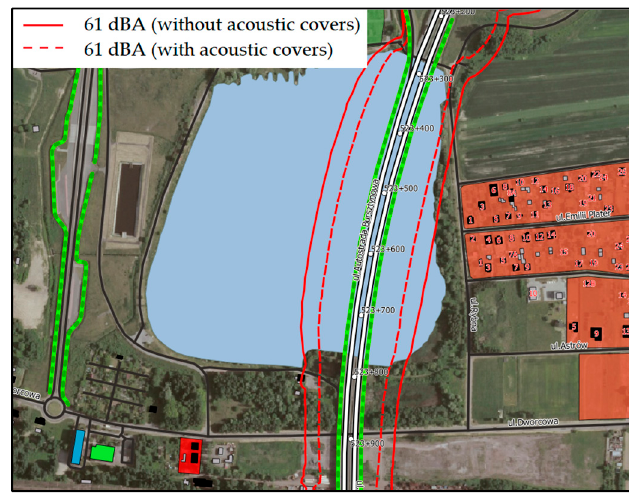
Figure 14. The results of the acoustic modeling—with and without the use of the acoustic covers on the expansion joints for a day.